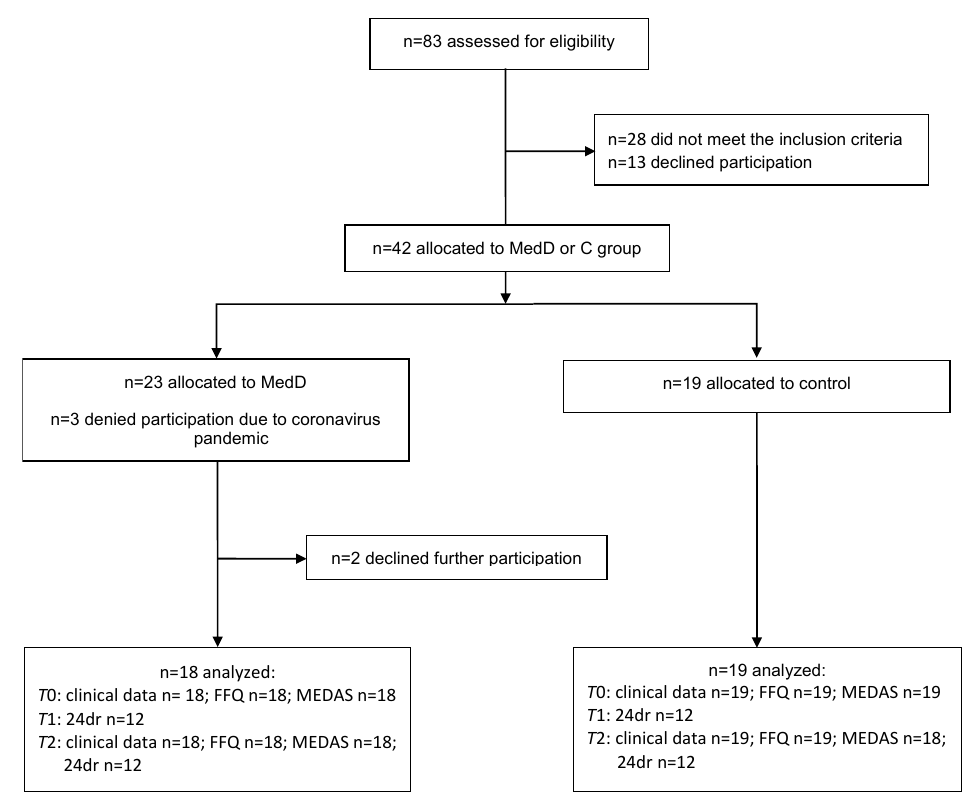
n=83 assessed for eligibility